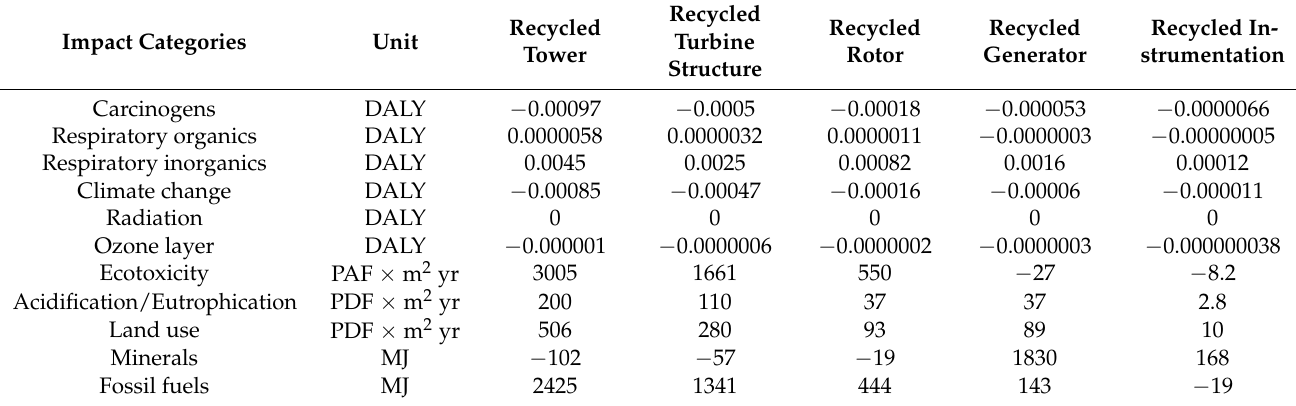
Table 3. Results of characterization of environmental consequences occurring in particular stages of the life cycle of an innovative 15 kW wind power plant, including categories of impacts with